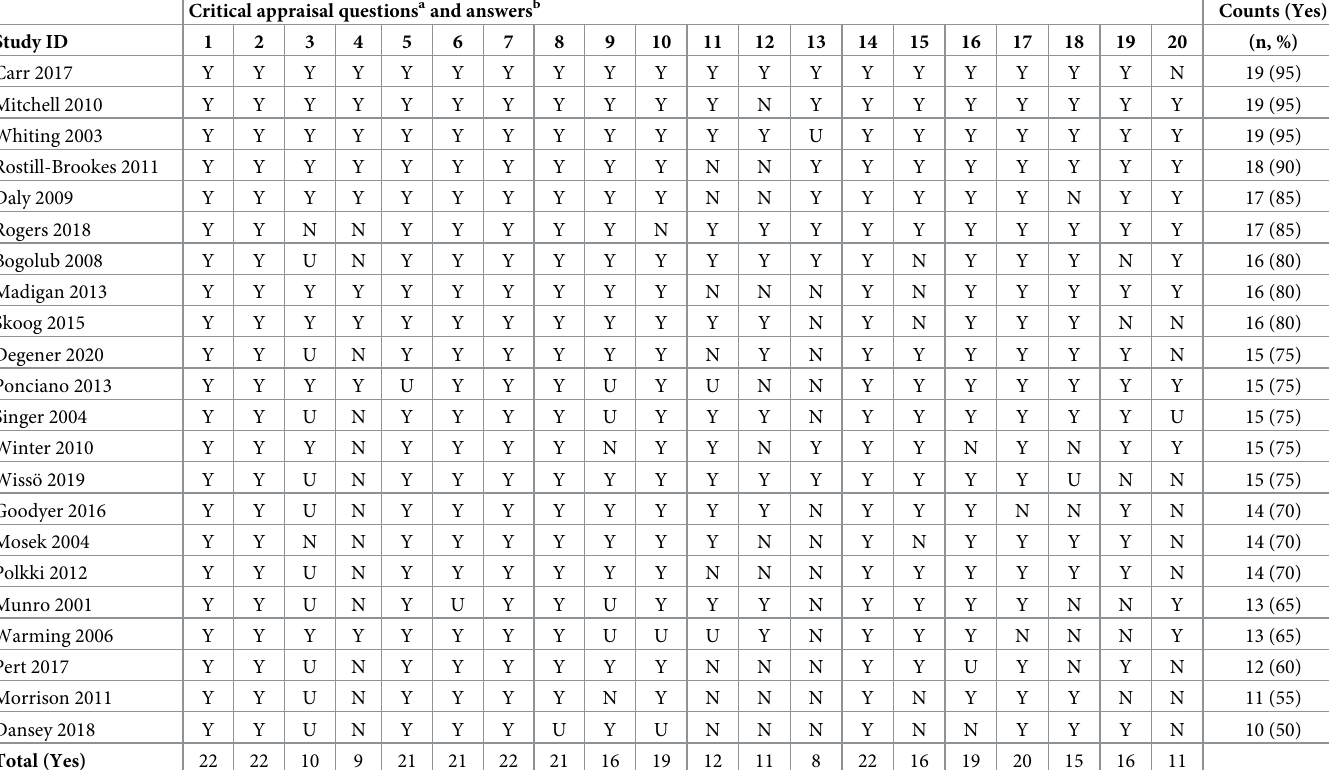
Table 2. Quality appraisal scores across included